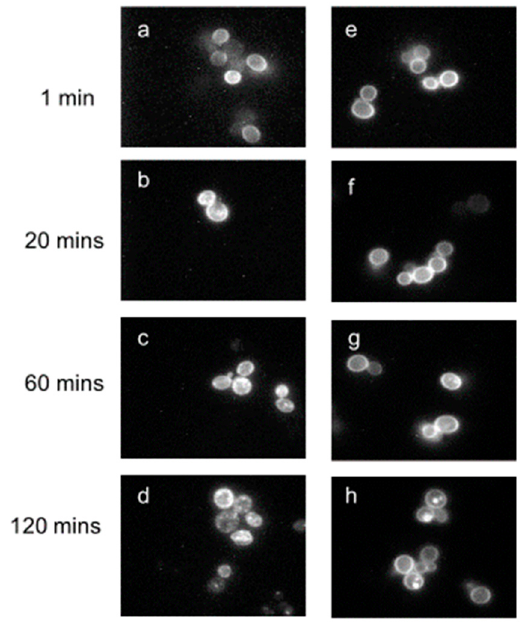
Figure 6. Endocytosis of [K7(NBD),Nle12] α -factor detected with fluorescence microscopy. Cells expressing full-length receptors (left panels) or truncated receptors (right panels) from multicopy plasmids were incubated with the fluorescent ligand at 30 °C for ( a , e ) 1, ( b , f ) 20, ( c , g ) 60, and ( d , h ) 120 min. The ranges of image intensities in panels ( e – h ) are approximately 2-fold greater than those for panels ( a – d ), indicative of the stronger fluorescence from the truncated receptors. Taken with permission from [70].